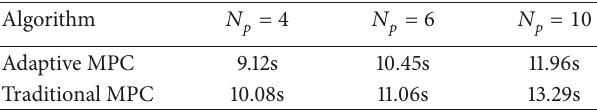
Table 3: Computation time of adaptive MPC and traditional MPC.